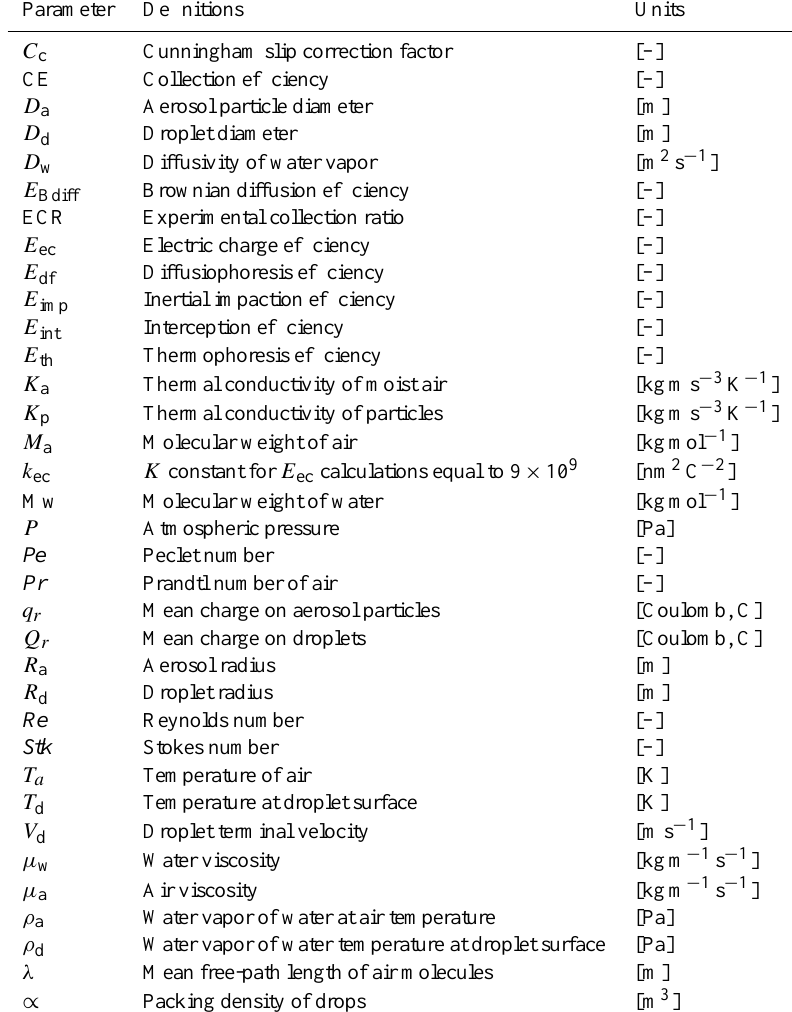
Table 2. Definition of acronyms and relevant